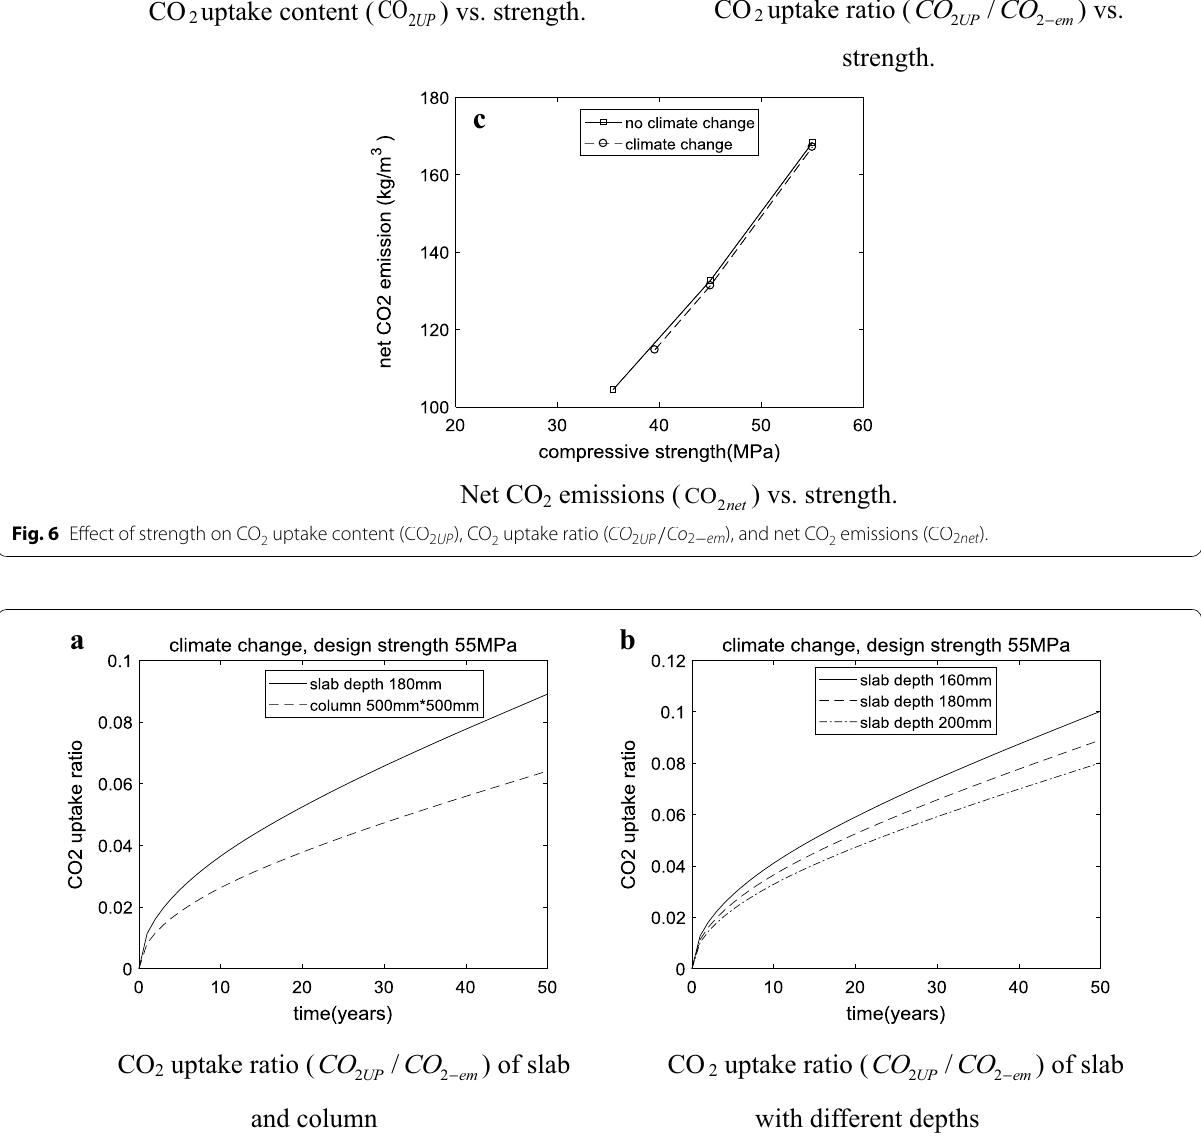
Fig. 7 Effect of structural element types on CO 2 uptake ratio ( CO 2 UP / Co 2 − em